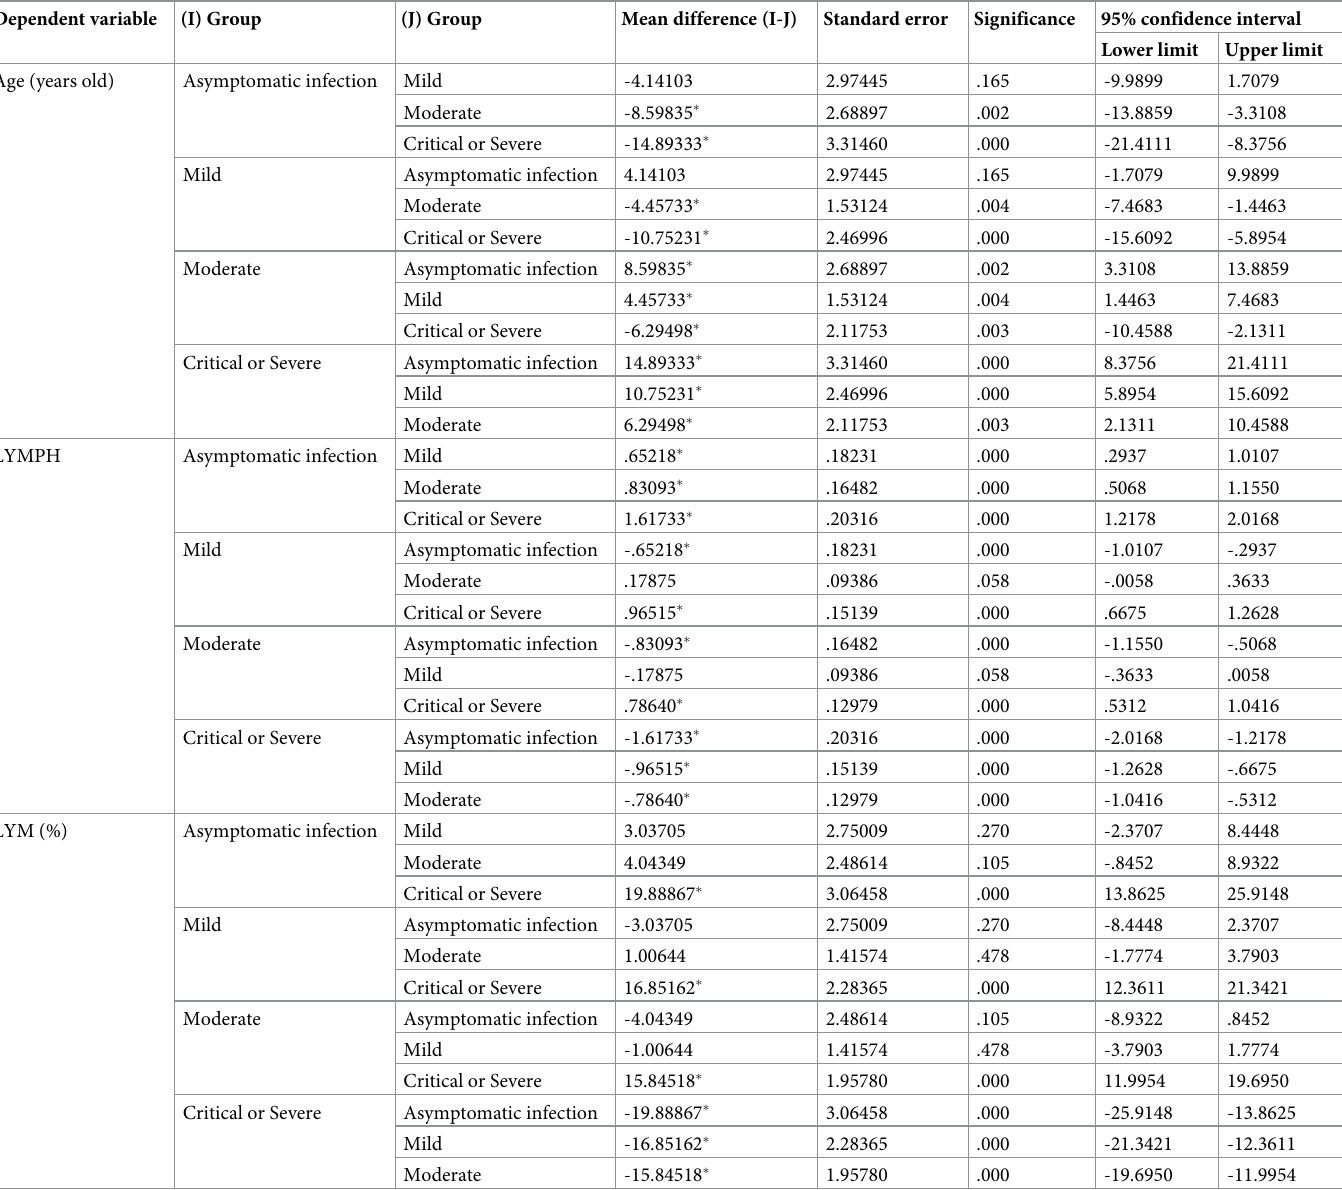
Table 4. Inter-group comparisons of age, LYMPH, and LYM% between groups with different levels of disease severity. Dependent variable (I)